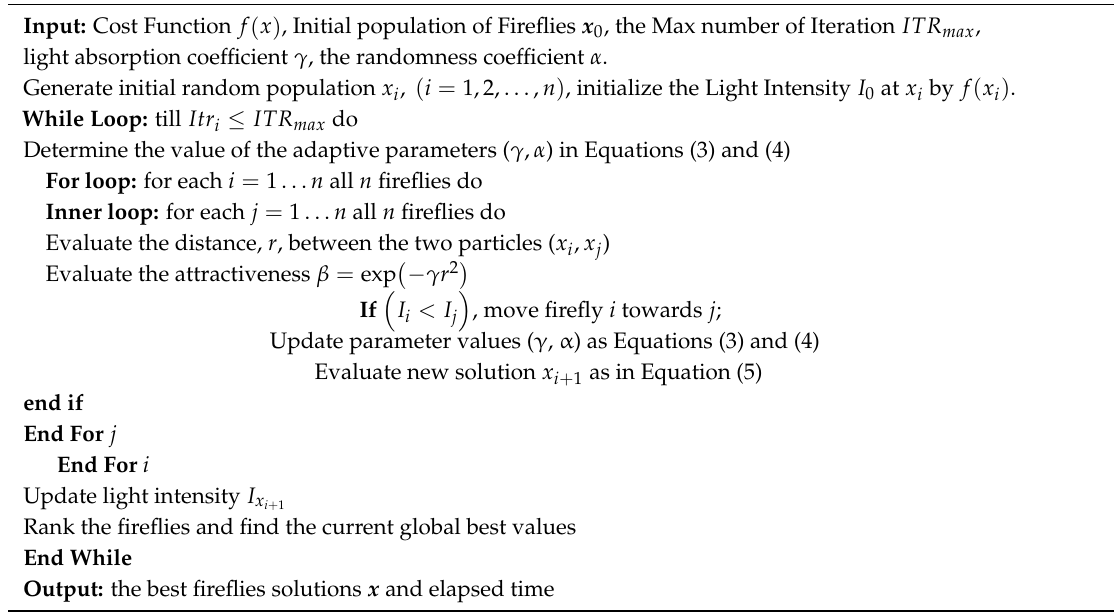
Algorithm 1: The Proposed Firefly Algorithm